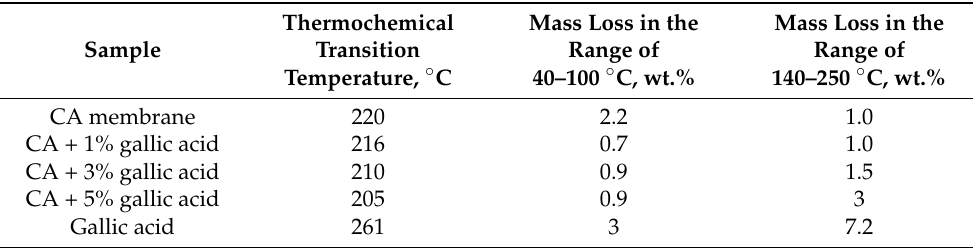
Table 2. Thermochemical transition temperature and mass loss within two different temperature ranges, for CA and CA-gallic acid